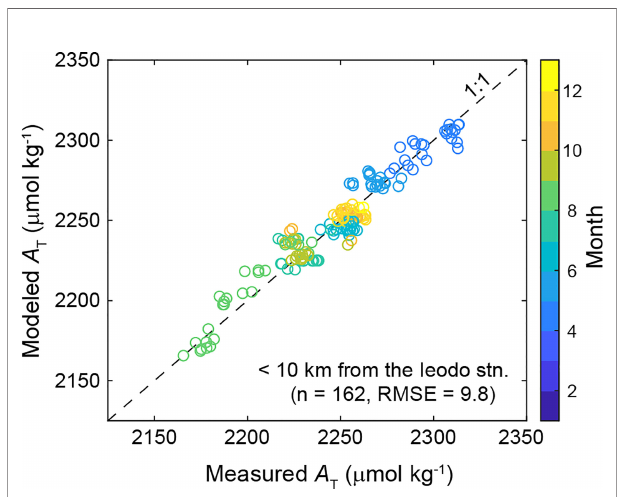
FIGURE 2 | Comparison between the measured and modeled surface A T in close proximity (< 10 km) to the Ieodo Ocean Research Station. The color of the symbols corresponds to the